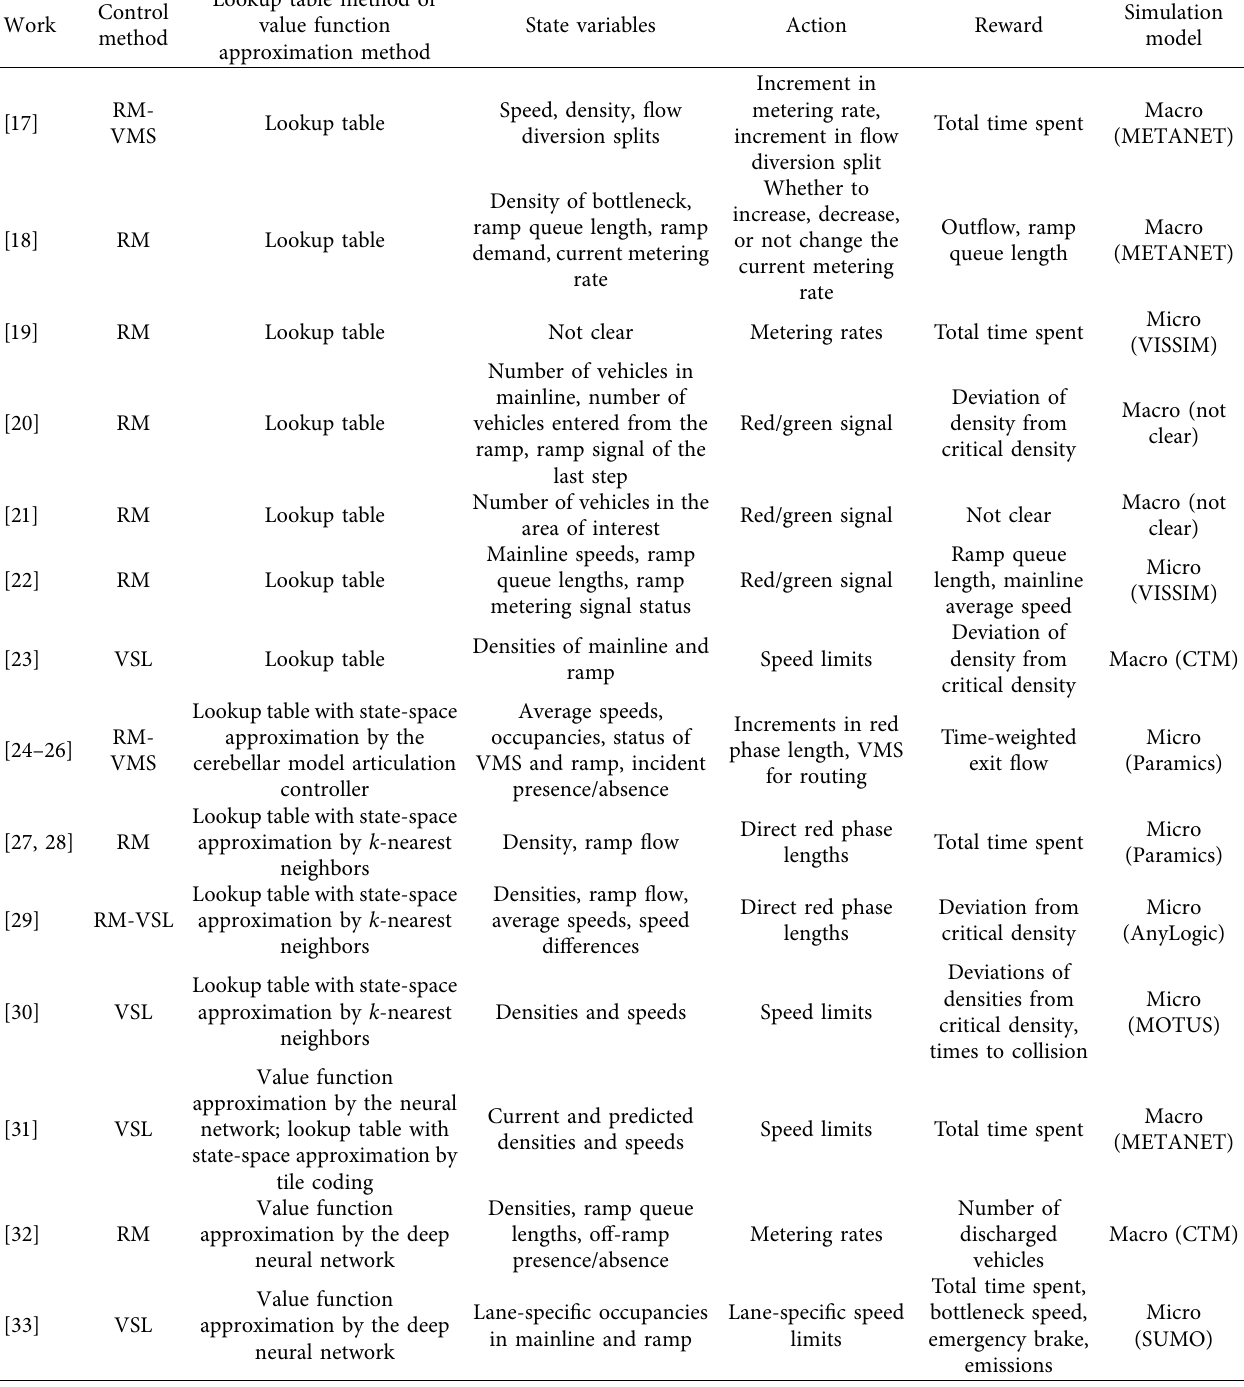
Table 1: Summary of Q-learning applications in freeway